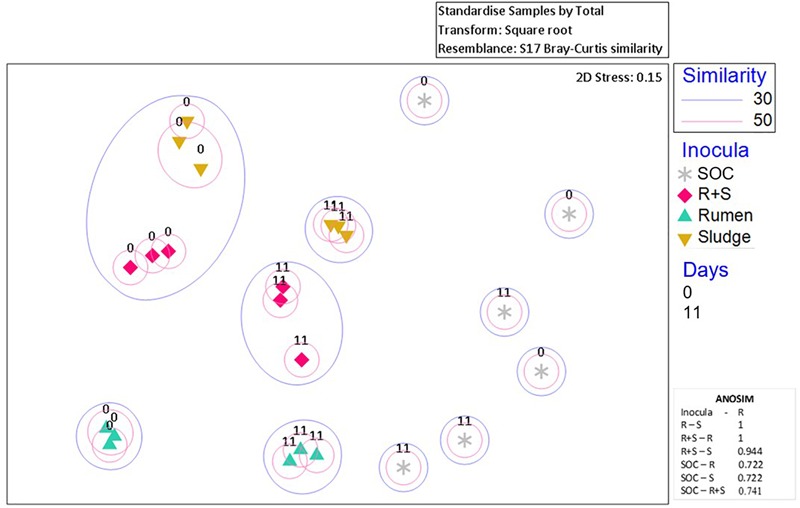
nMDS plot of incubation communities at the time zero (denoted by “0”) and the time of maximal EtOH production (denoted by “11”). Blue or pink circles encompass communities which share 30 and 50% similarities, respectively. The 2D stress value indicates good representation of the data on these 2D nMDS plots. ANOSIM R values (0.1% significance level) range from 0 to 1 where 1 = high dissimilarity between clusters. R, rumen pH 7; S, sludge pH 5.5; R + S, mixed-source community pH 5.5; SOC, substrate only control.